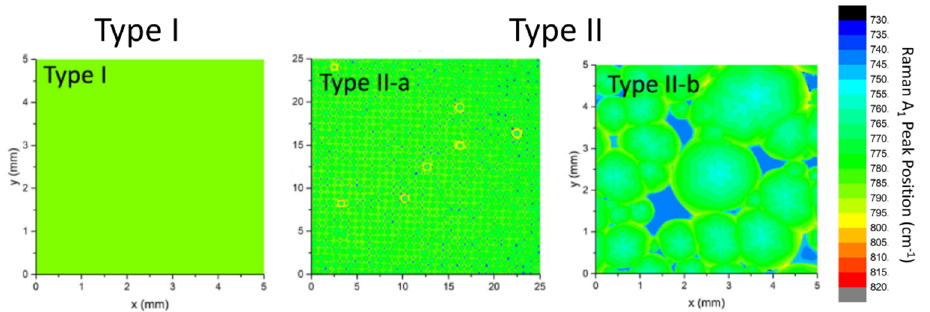
Figure 3. Optical profilometry, PL imaging, and Raman A 1 (LO) mapping of four early substrates. Figure uses copyrighted images, reprinted from [16] with permission from Elsevier.